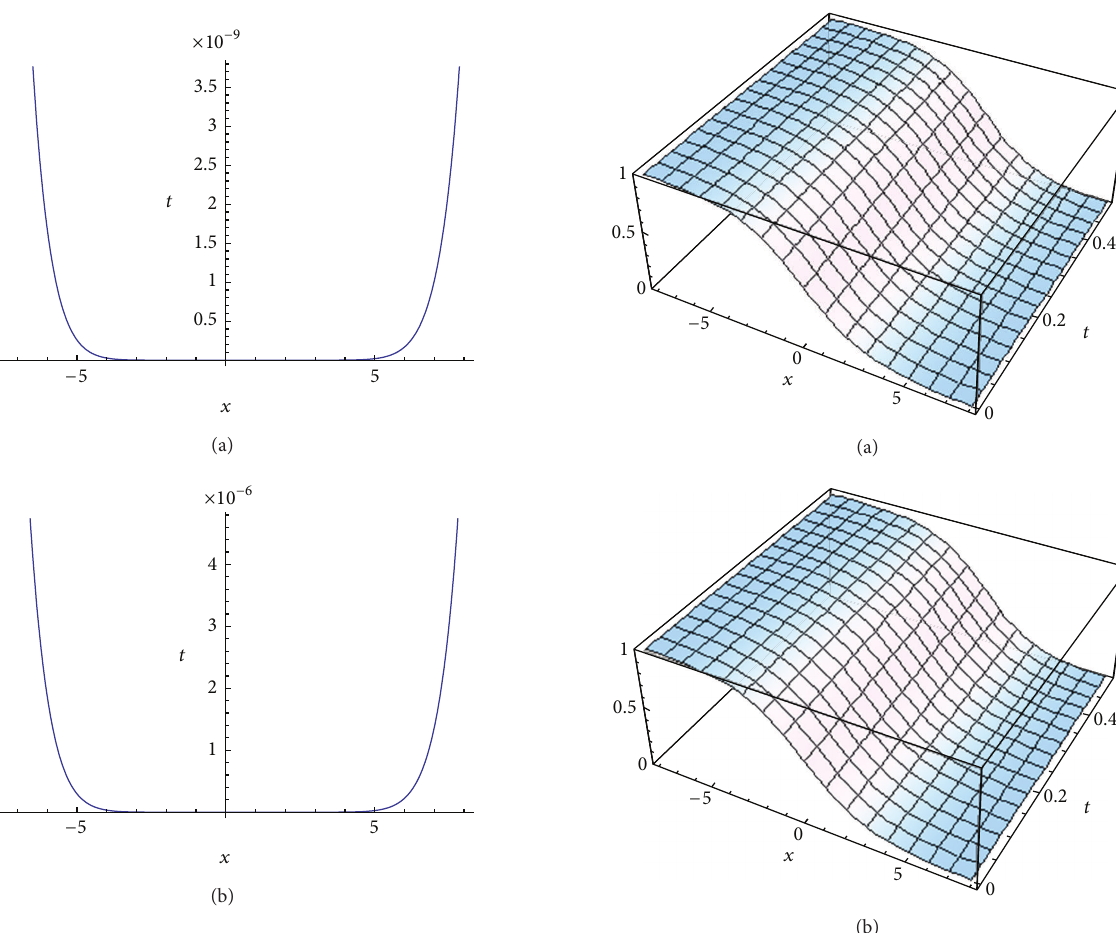
(𝑥,𝑡) are shown, respectively, from (b) to Figure 7: 𝑢(𝑥,𝑡) and 𝑢 app (a), when −5 ≤ 𝑥 ≤ 5 and 0 ≤ 𝑡 ≤ 0.5 , for NW equation, with 𝑛 = 11